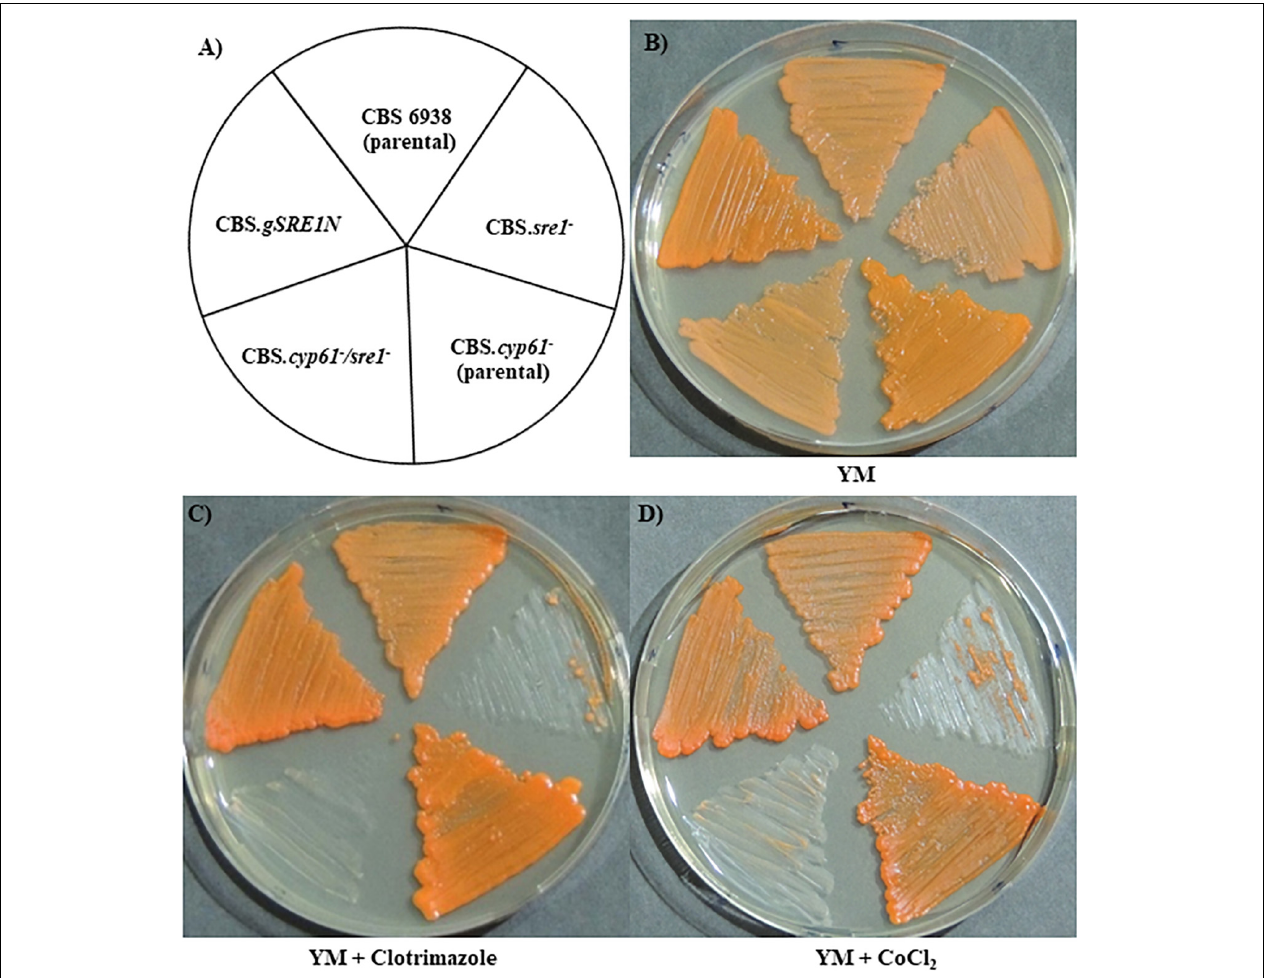
FIGURE 5 | Growth phenotype of X. dendrorhous strains. Plates were incubated for 5 days at 22 ◦ C. (A) Scheme indicating the position of the seeded strains, and cultures on (B) YM medium and on YM medium supplemented with (C) clotrimazole (0.15 µ g/ml) or (D) cobalt chloride (400 µ M).